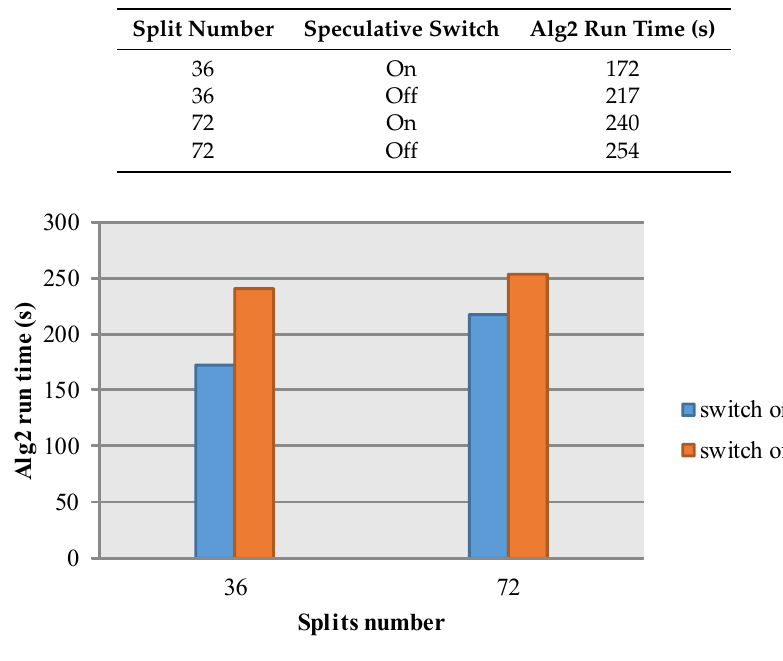
Table 7. Experiment configuration.